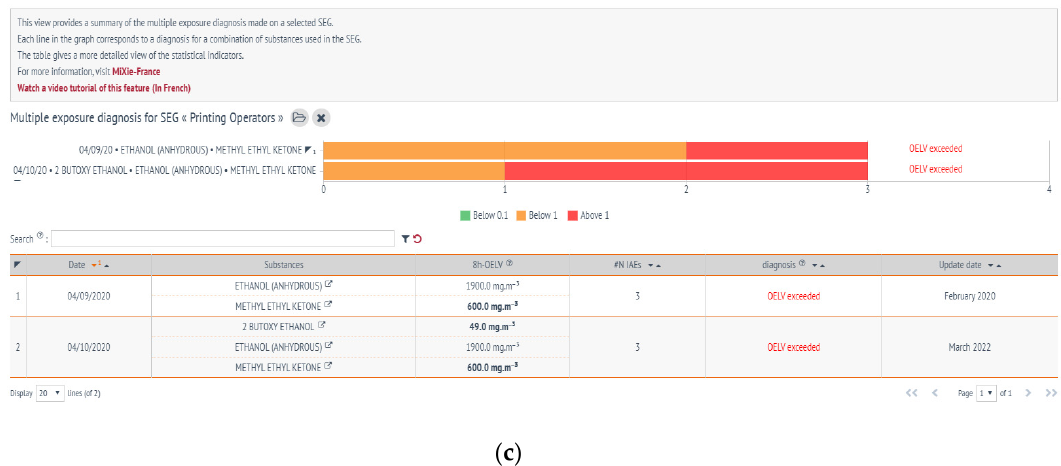
Figure 5. Assessing exposure during maintenance tasks in the printing industry with AltrexChimie. On the top ( a ), the cartography and the SEG, with the details of the protective equipment and substances shown. On the top ( b ), example of multiple exposure diagnostic with three substances. On the bottom ( c ), an example of the multiple exposure dashboard with two exposure diagnostics, for different combinations of substances.